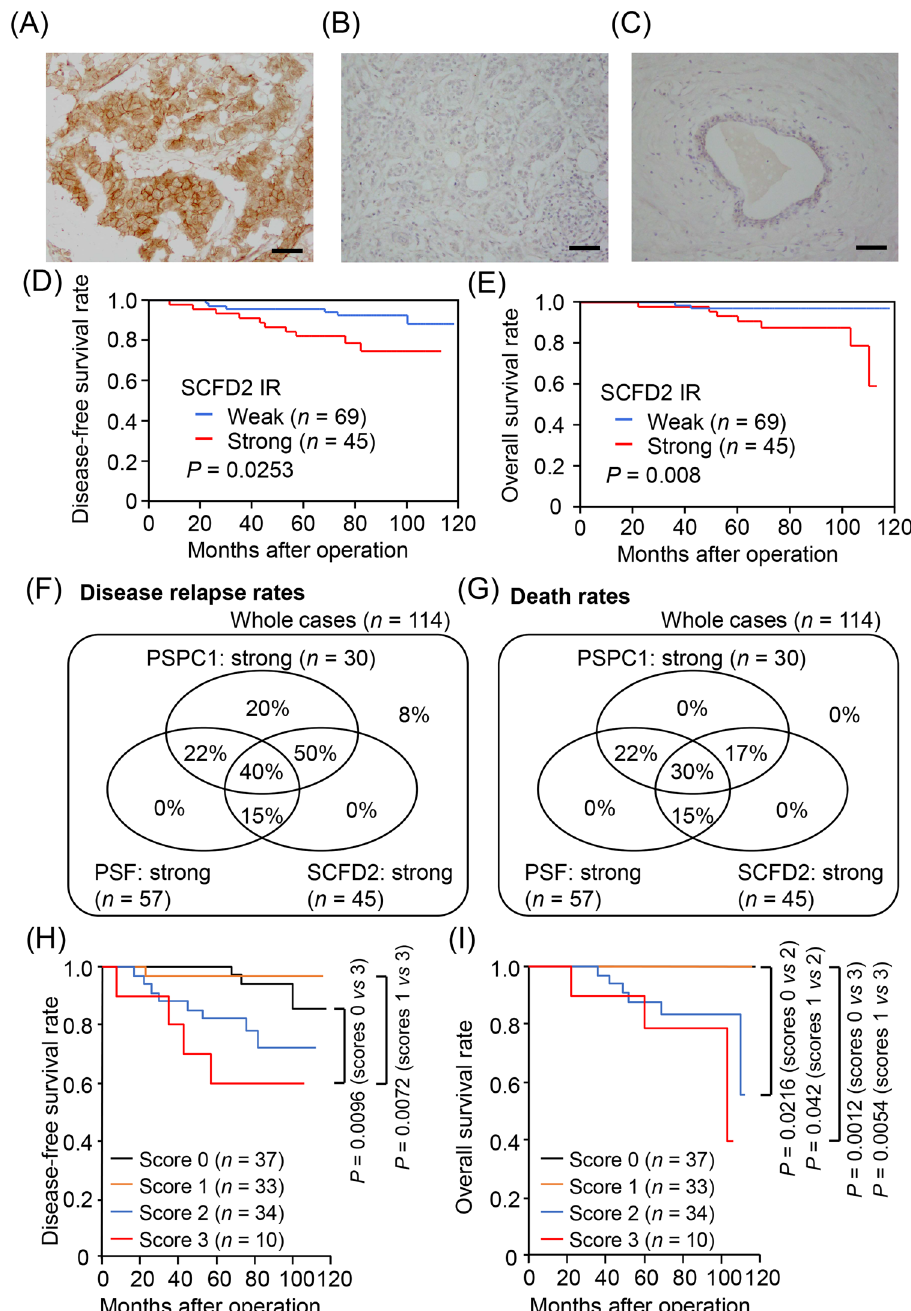
Figure 3. SCFD2 is a potential prognostic factor of ER-positive breast cancer patients and combinations of PSPC1/PSF/SCFD2 IRs are potently associated with poor prognosis in ER-positive breast cancer patients. ( A – C ) Representative images of ER-breast tumor sections with strong ( A ) and weak ( B ) SCFD2 IR and benign breast duct ( C ). Scale bar, 50 μm. ( D , E ) Kaplan–Meier plots for disease-free ( D ) and overall ( E ) survivals of ER-positive breast cancer patients with weak and strong SCFD2 IR ( n = 69 and 45, respectively). ( F , G ) Disease relapse rates ( F ) and death rates (G) among ER-positive breast cancer patients categorized by PSPC1/PSF/ SCFD2 IR status. ( H , I ) Kaplan–Meier plots for disease-free ( H ) and overall ( I ) survivals of ER-positive breast cancer patients categorized by PSPC1/PSF/SCFD2 IR scores. Score 0: weak IR for all three proteins, score 1: strong IR for any single protein of PSPC1/PSF/SCFD2, score 2: strong IR for any two proteins of PSPC1/PSF/ SCFD2, and score 3: strong IR for all three proteins. For multiple comparisons, significance is assessed at P < 0.05 following Bonferroni